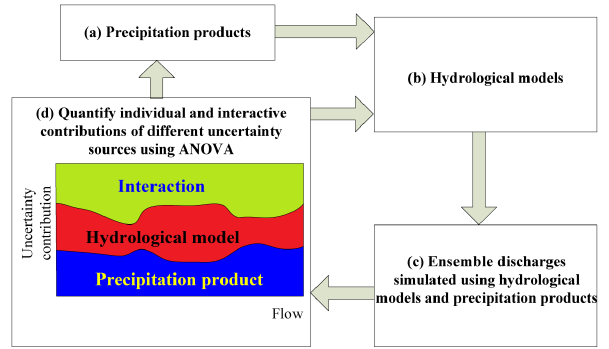
Figure 2. Diagrammatic flowchart of the proposed framework for quantification of uncertainty contributions to ensemble discharges simulated using precipitation products on the basis of the analysis of variance (ANOVA)